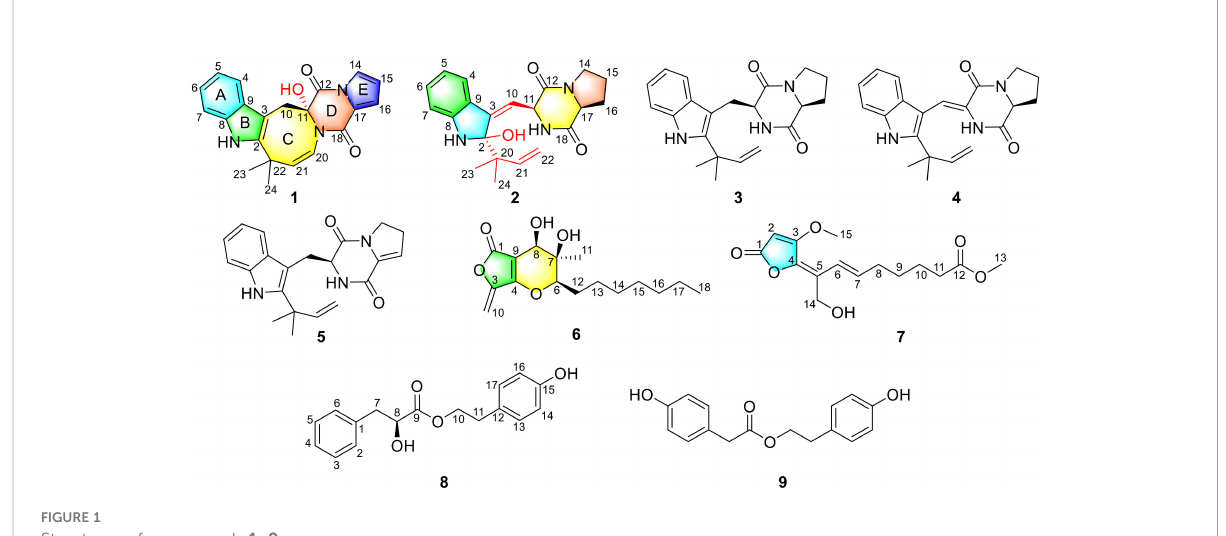
FIGURE 1 Structures of compounds 1 − 9